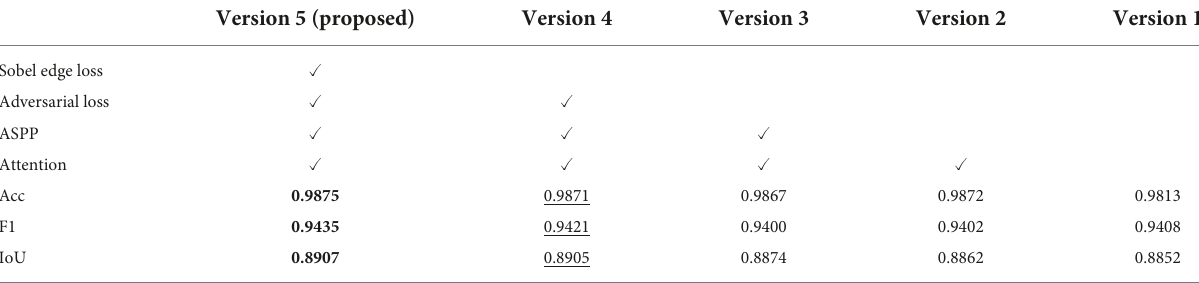
TABLE 1 Component and training strategy ablation experiments in WHU building